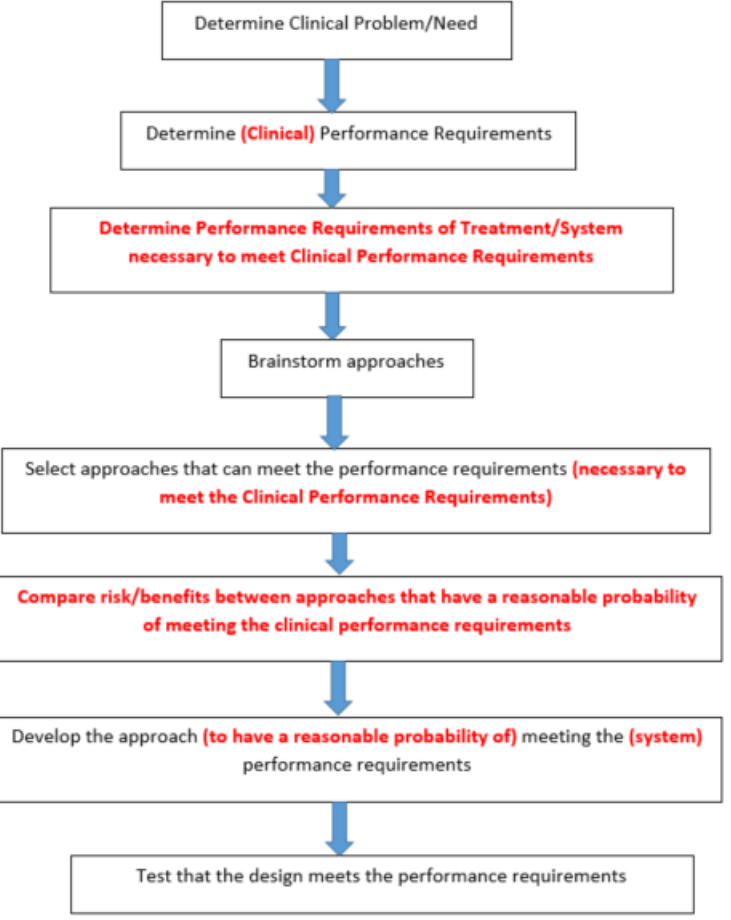
Figure 8. The Engineering Design Process.